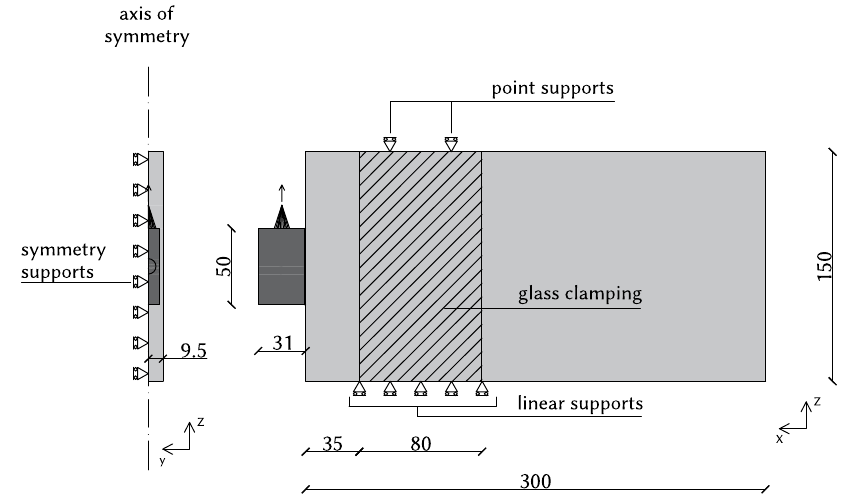
Fig. 10 Geometry, dimensions and boundary conditions of the model (units in